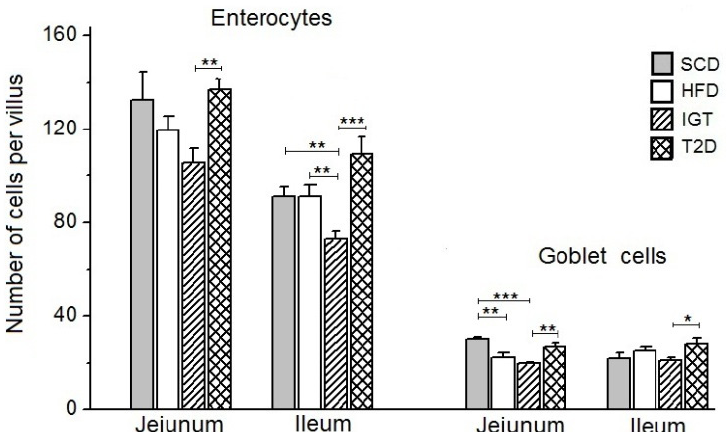
Figure 4. The number of enterocytes and goblet cells in the villi of the jejunum and ileum in the rats with type 2 diabetes (T2D), with impaired glucose tolerance (IGT) and in control groups: high-fat diet (HFD) and standard chow diet (SCD). The T2D group ( n = 4), the IGT group ( n = 6), the HFD group ( n = 6) and the SCD group ( n = 6). Results are expressed as means ± the standard error of the mean (SEM). Student t -test: * p < 0.05, ** p < 0.02 and *** p < 0.0027.